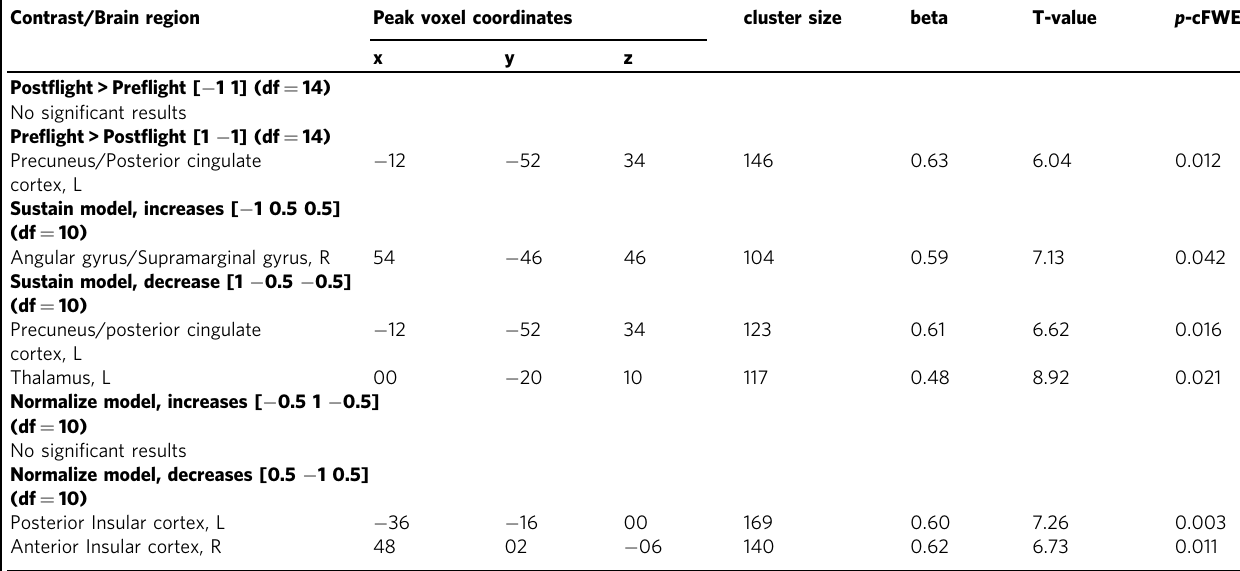
Peak voxels of clusters showing modulations in ICC values between various contrasts among the three scanning sessions in the cosmonaut cohort (pre fl ight, post fl ight, follow-up). Brain region labeling was based on the Neuromorphometrics atlas. Beta values represent the effect size; T-values are cluster-averaged; p -cFWE: p -value after cluster-wise family-wise error (FWE) correction. This threshold was set at p <0.05. df = degrees of freedom. R = right, L = Left. Bold fonts are used as headers to de fi ne the exact test that was